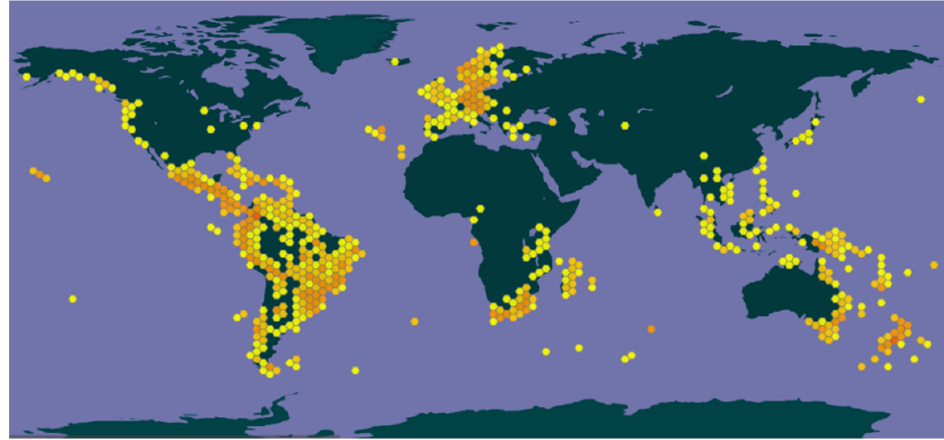
Figure 2. Distribution of Blechnum species (GBIF).